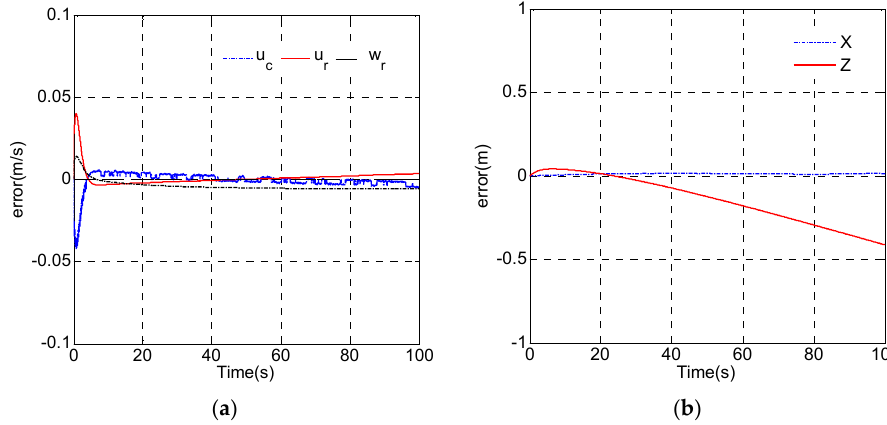
Figure 24. Observed error of velocity and position: ( a ) velocity error; ( b ) position error.